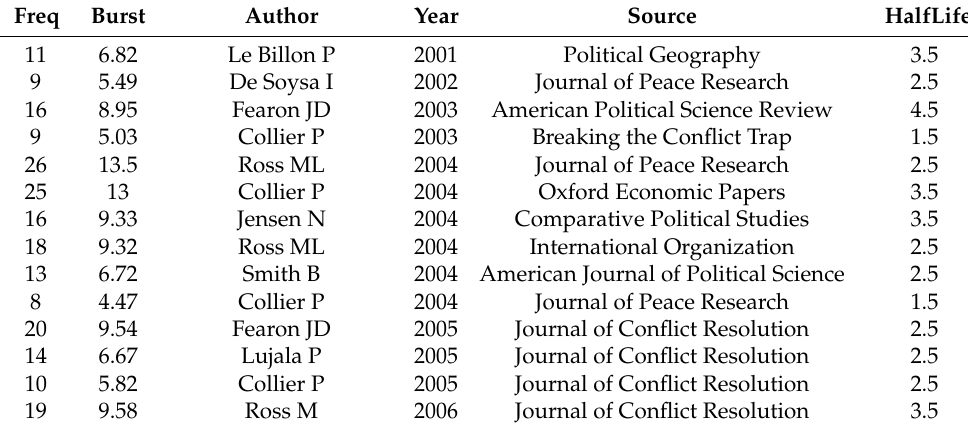
Table 9. Exploration and summary of Cluster